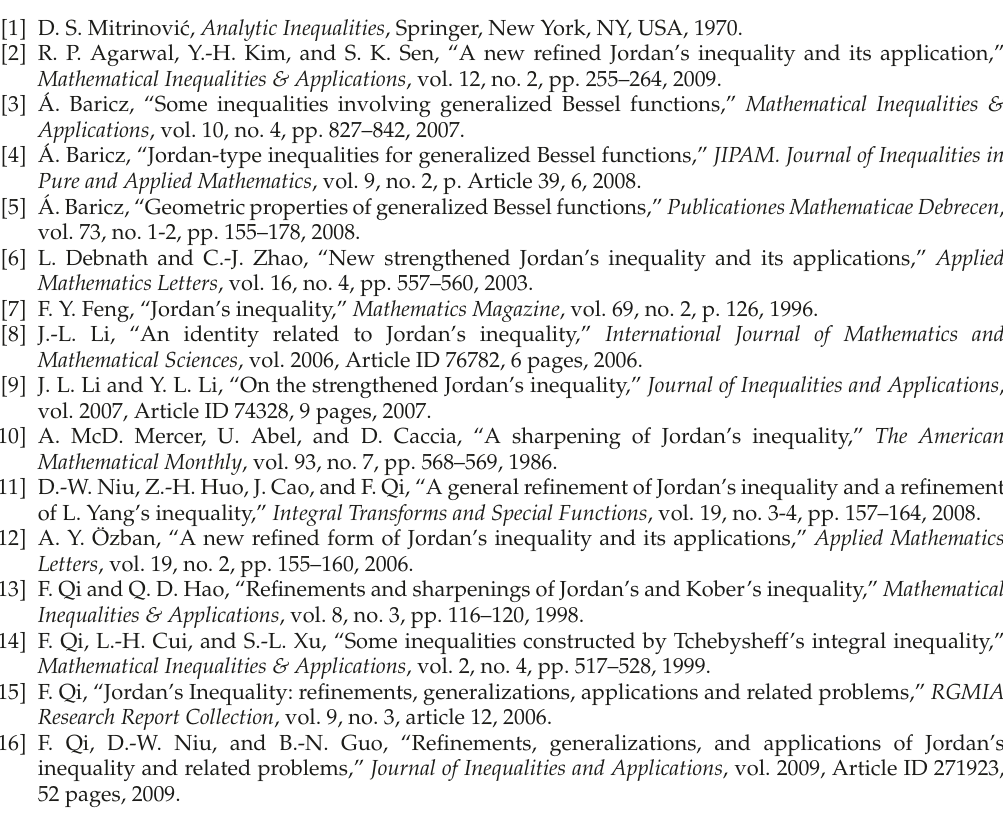
Figure 3: The residual error (cid:5) sin x − p